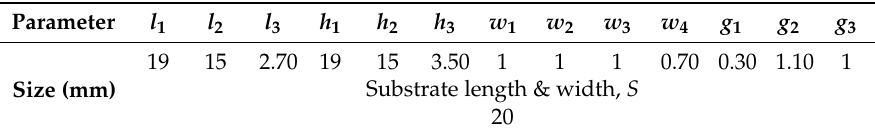
Table 1. Dimension of Ring C-shaped quasi-TEM